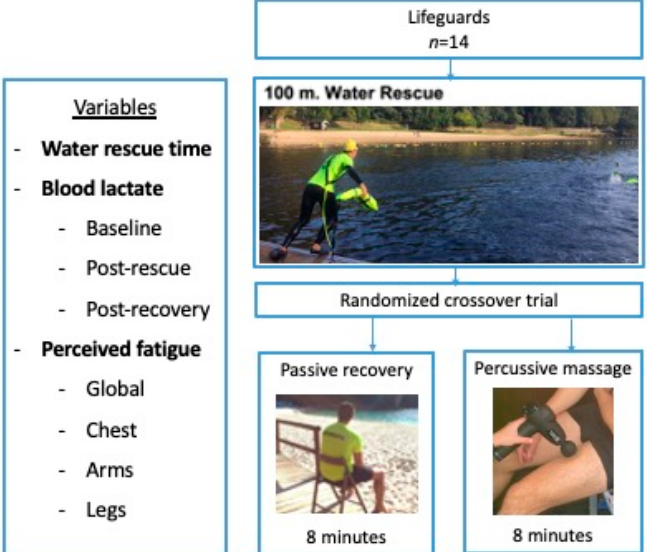
Figure 1. Flow chart outlining the design, intervention and